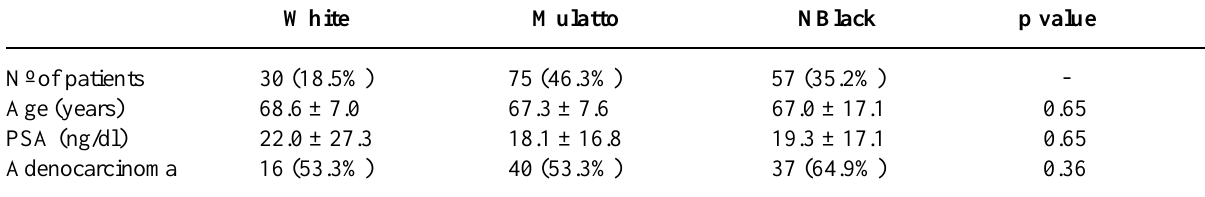
Table 4 – Pathological data and age range of 162 patients submitted to prostatic biopsy according to race.